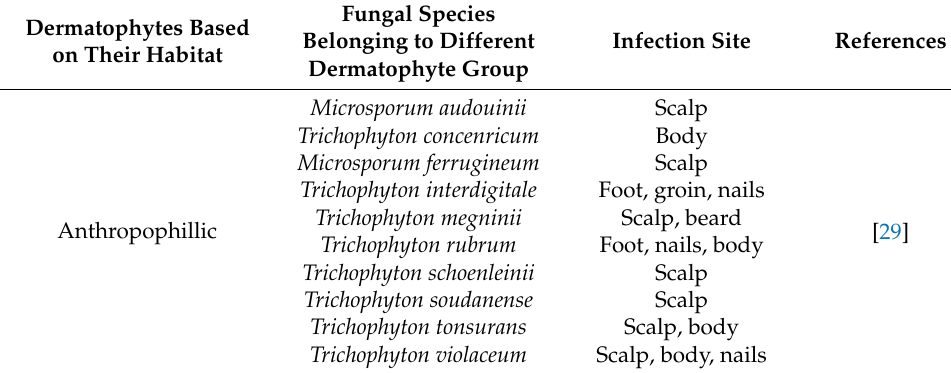
Table 2. Most relevant species of fungal infection according to their natural